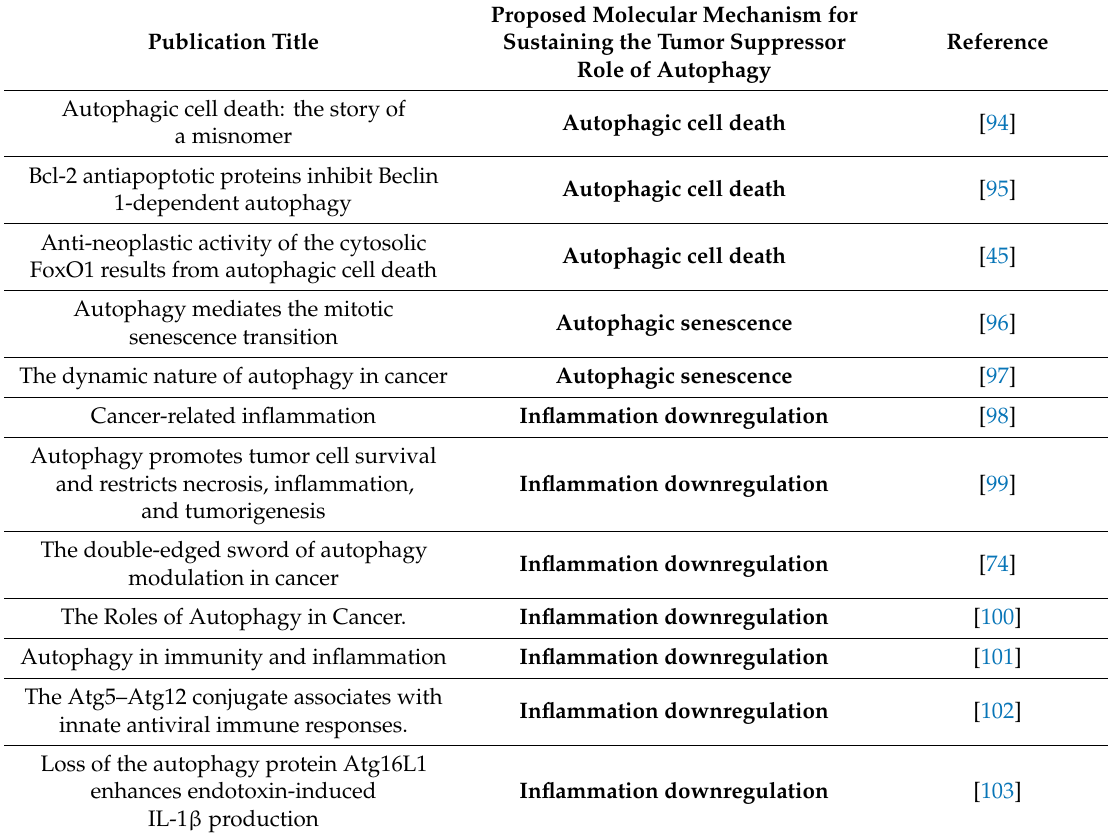
Table 2. Summary of analyzed publications highlighting the tumor suppressor role of